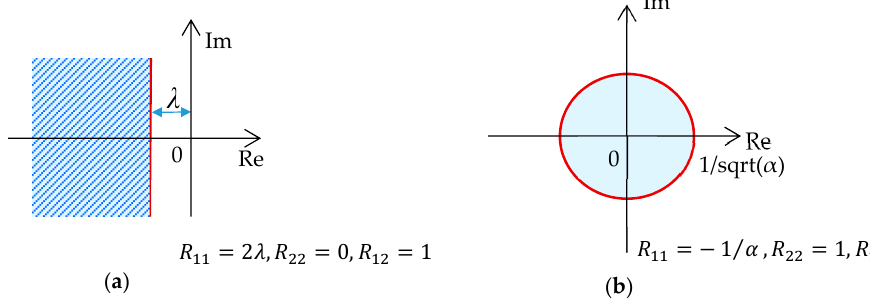
Figure 1. Stable system pole regions. ( a ) Continuous-time system: Open left half plain of the convex plane; ( b ) discrete-time systems: Interior of the unit circle.